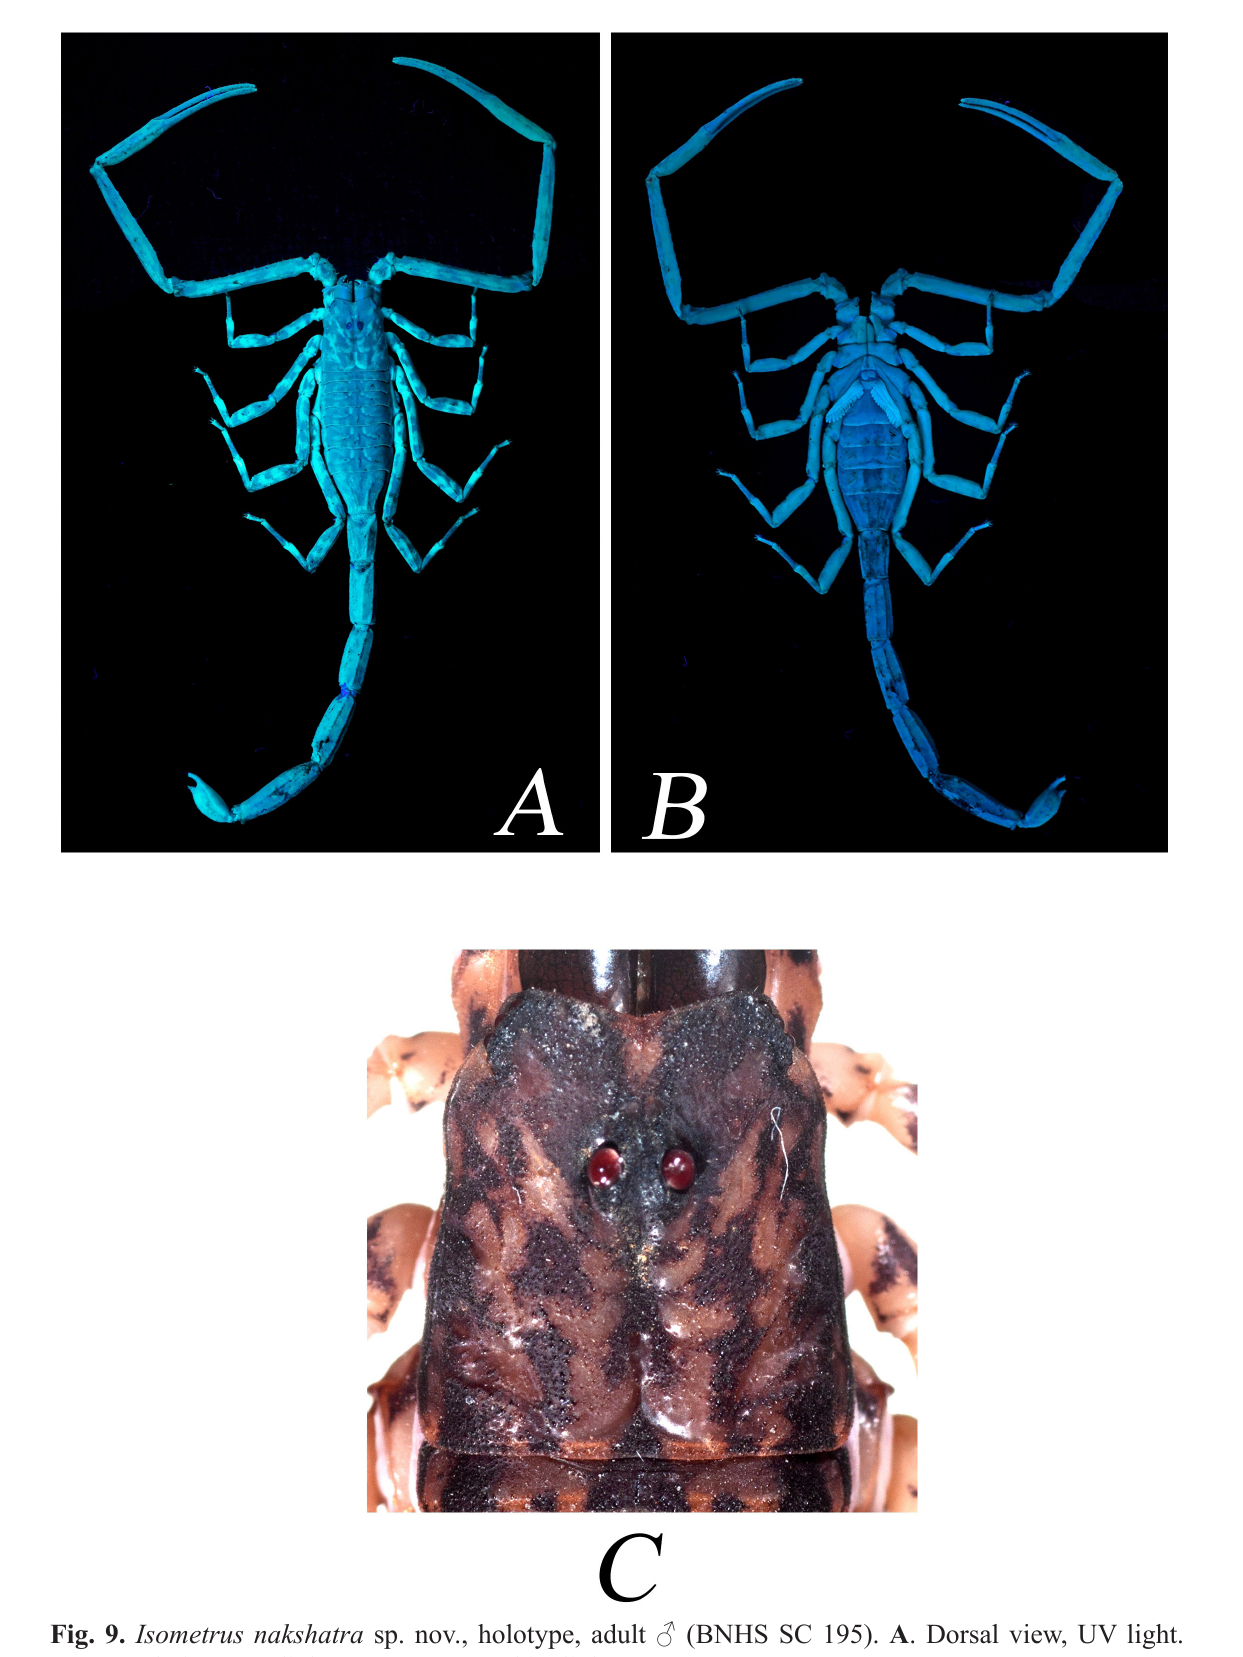
Fig. 9. Isometrus nakshatra sp. nov., holotype, adult ♂ (BNHS SC 195). A . Dorsal view, UV light. B . Ventral view, UV light. C . Carapace, white